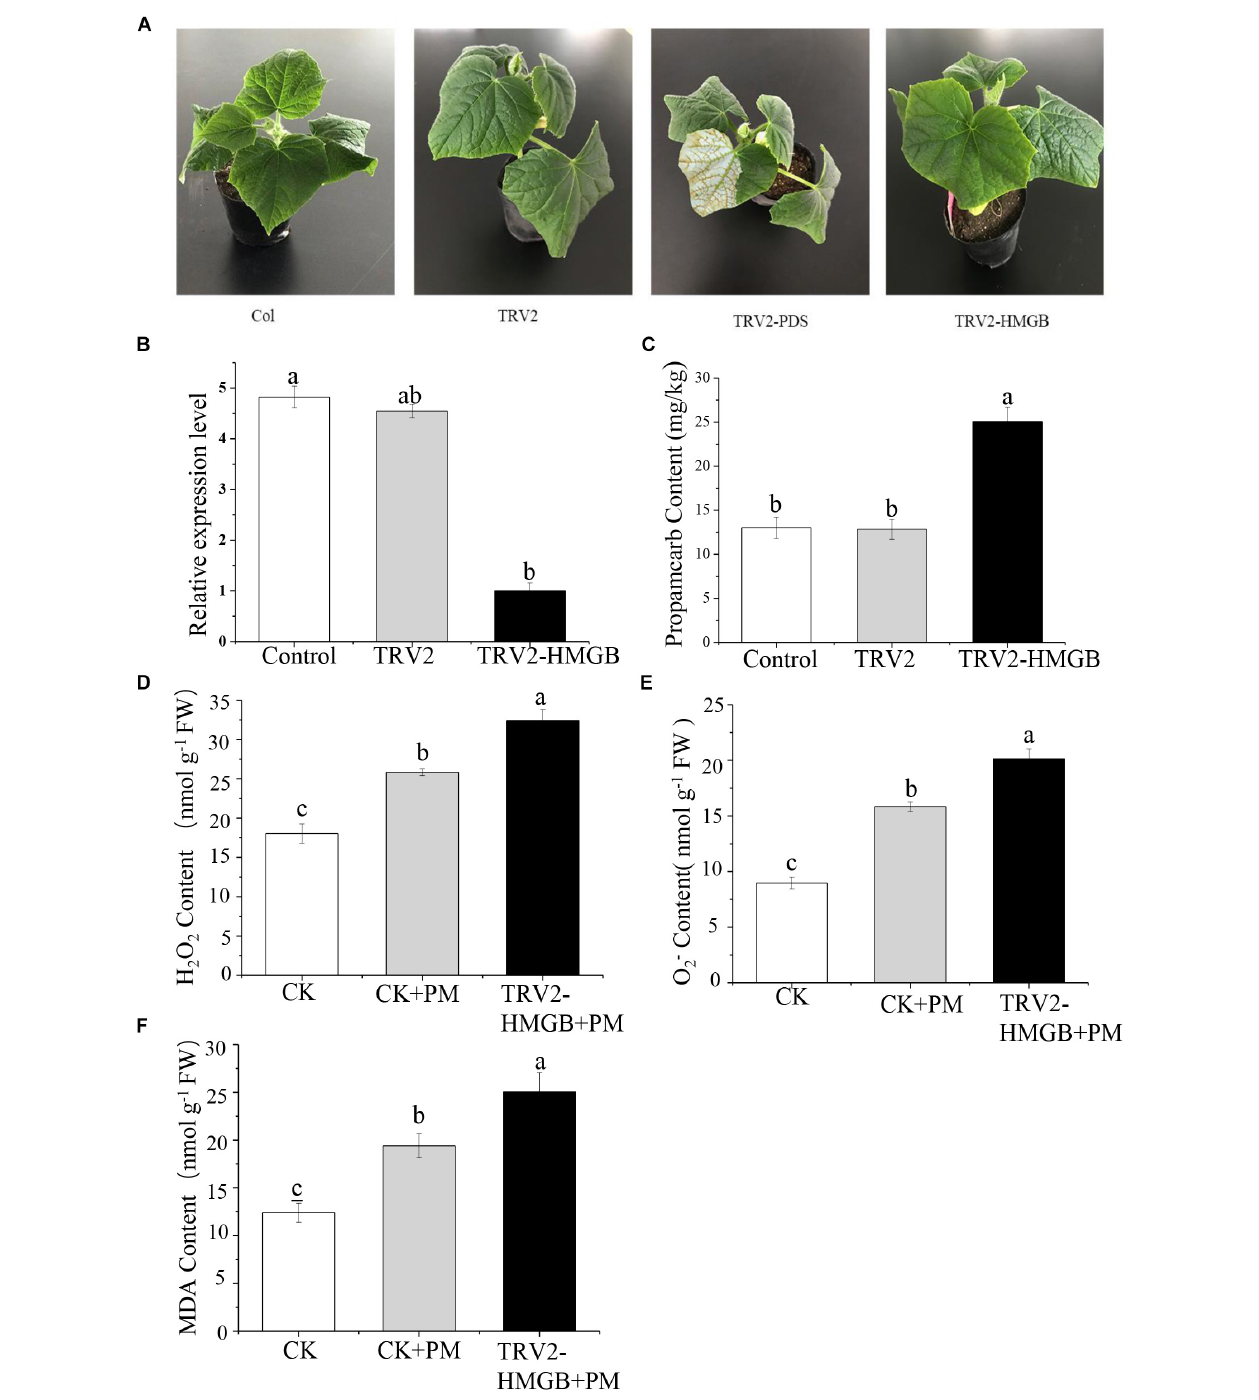
FIGURE 5 | Silencing of CsHMGB in leaves of “D0351” plants. (A) Color fading phenotypes via PDS control gene 16 days after inoculation of leaves. (B) CsHMGB levels in CsHMGB -silenced, pTRV2 and control plants. (C) Propamocarb contents in leaves of CsHMGB -silenced, pTRV2, and control plants at 2 days. (D) O 2 − contents in leaves under propamocarb stress. (E) H 2 O 2 contents in leaves under propamocarb stress. (F) MDA contents in leaves under propamocarb stress. Different letters indicate significant differences between genotypes ( p < 0.05 by Tukey’s test). Error bars represent SE.